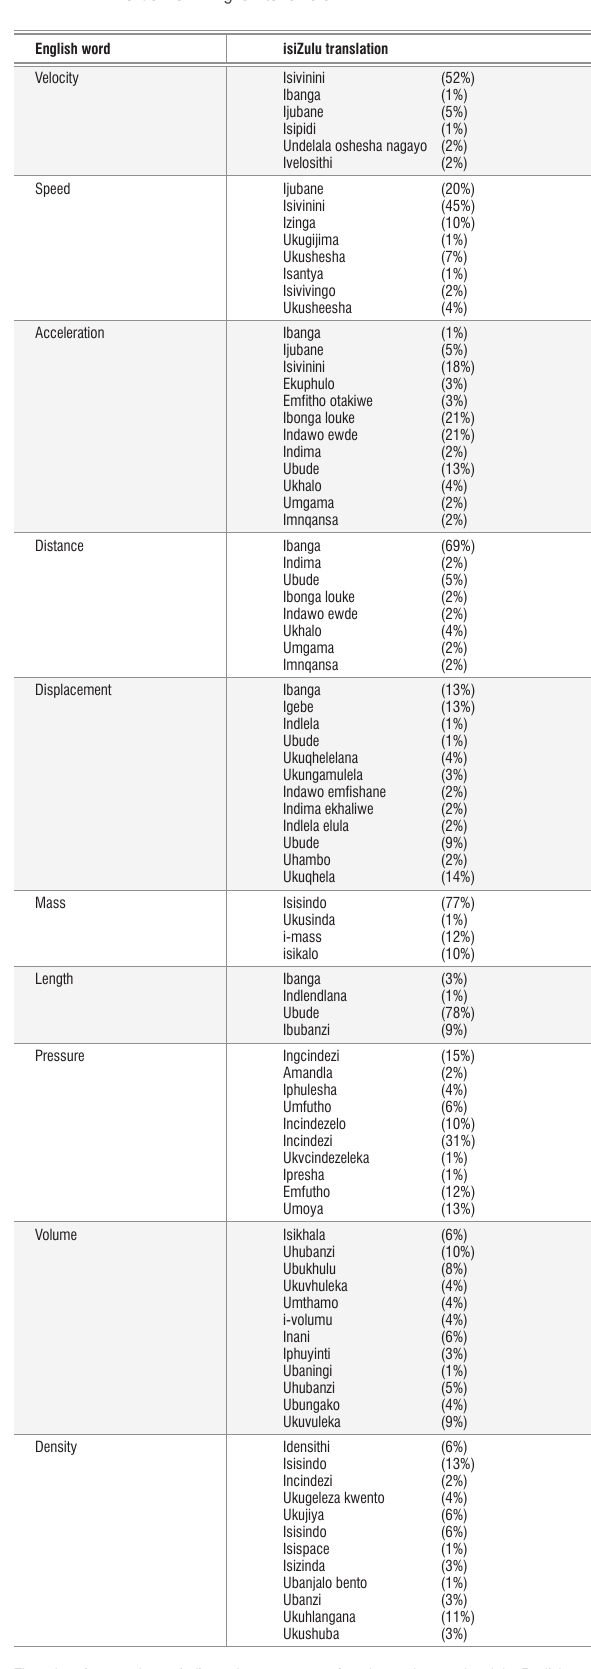
Table 4: Students’ responses when asked to translate common physics words from English to